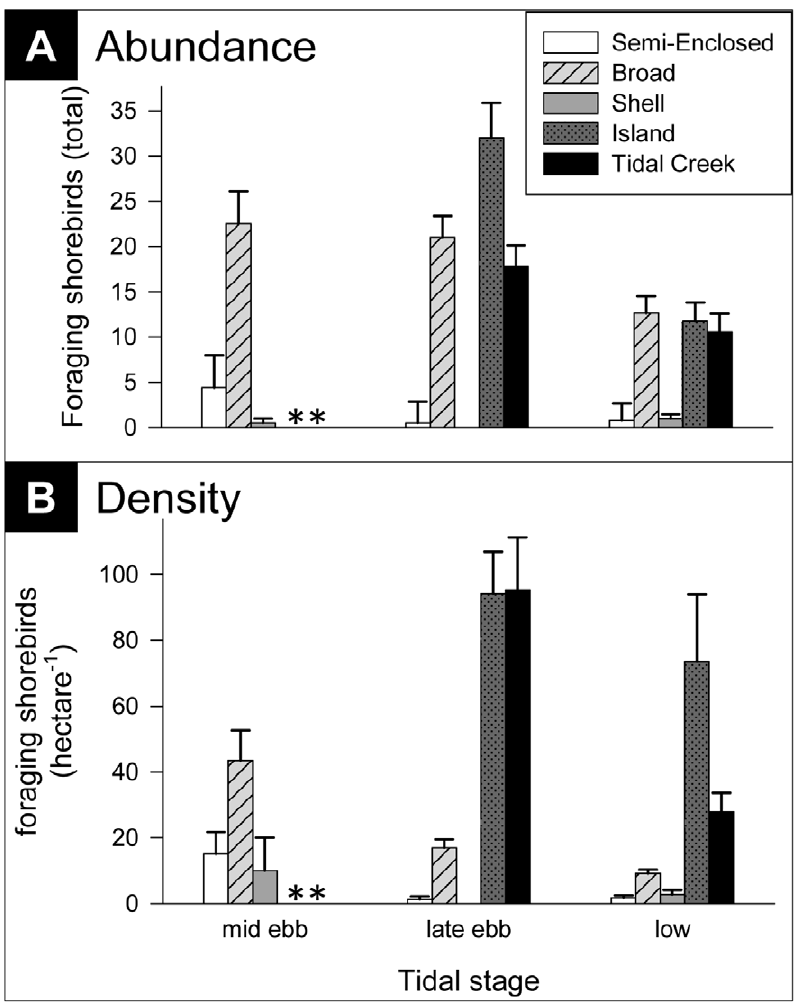
Figure 6. Mean foraging shorebird (A) abundances and (B) densities, by flat and tidal stage. Shell Flat is plotted for comparison only; it was not included in statistical tests due to low sample size when fisherman disturbance dates were excluded. Asterisks indicate submerged